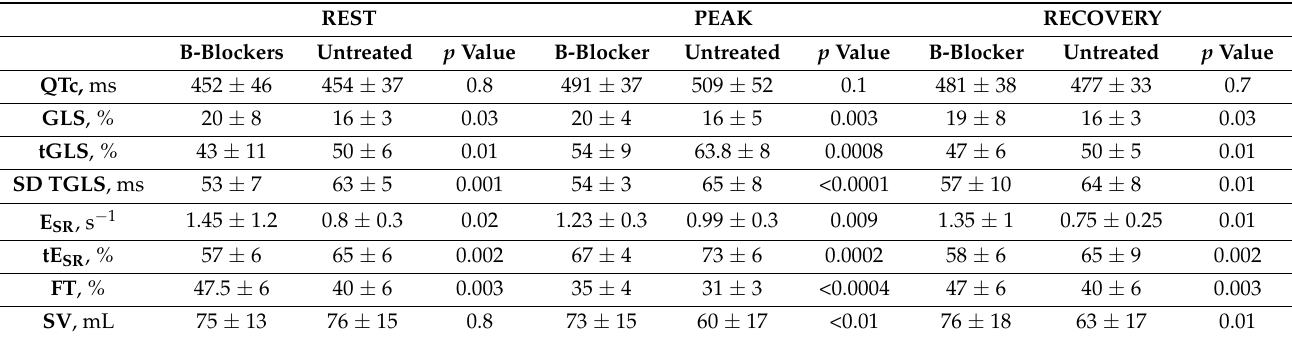
Table 3. Comparisons between patients with LQTS treated with B-blockers and those that were untreated at rest, peak exercise, and four minutes into recovery.